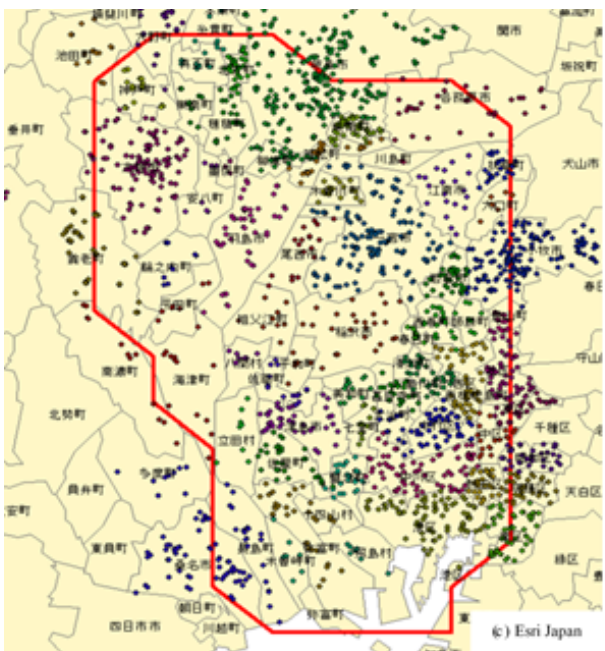
Figure 2. Analysis area and distribution of